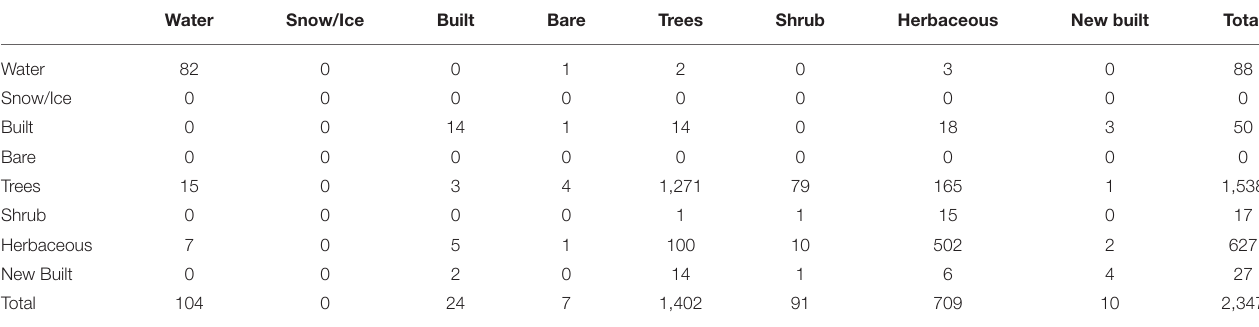
TABLE 2 | Confusion matrix expressed as sample counts with reference observations in the columns and map values in rows.